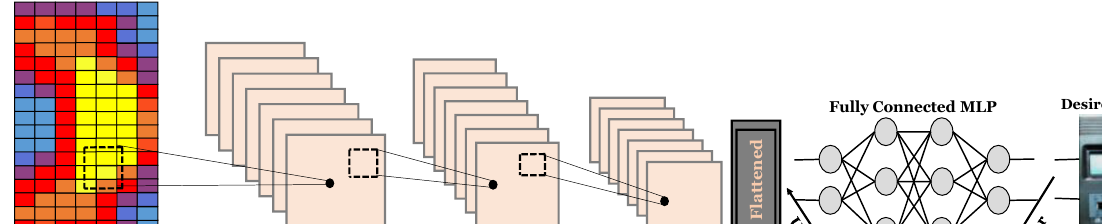
N o Y e s Figure 4. The flowchart of the proposed NSBPSO algorithm. Therefore, Equation (1) is updated as follows and two new vectors are added to improve the PSO performance. Motion towards the best onlooker bee (from the neigh- borhood search operator) improves the algorithm ’ s exploitation. Motion to the best em- ployed bee from the multi-parent crossover operator improves the algorithm ’ s explora- tion. Figure 5 shows the flowchart of the proposed NSBPSO algorithm. 𝑉 𝑖𝑑 (t + 1) = α𝑉 𝑖𝑑 (t) + βrand(0, φ 1 )(𝑃 𝑖𝑑 (𝑡) − 𝑋 𝑖𝑑 (𝑡)) + βrand(0, φ 2 )(𝑃 𝑔𝑑 (𝑡) −